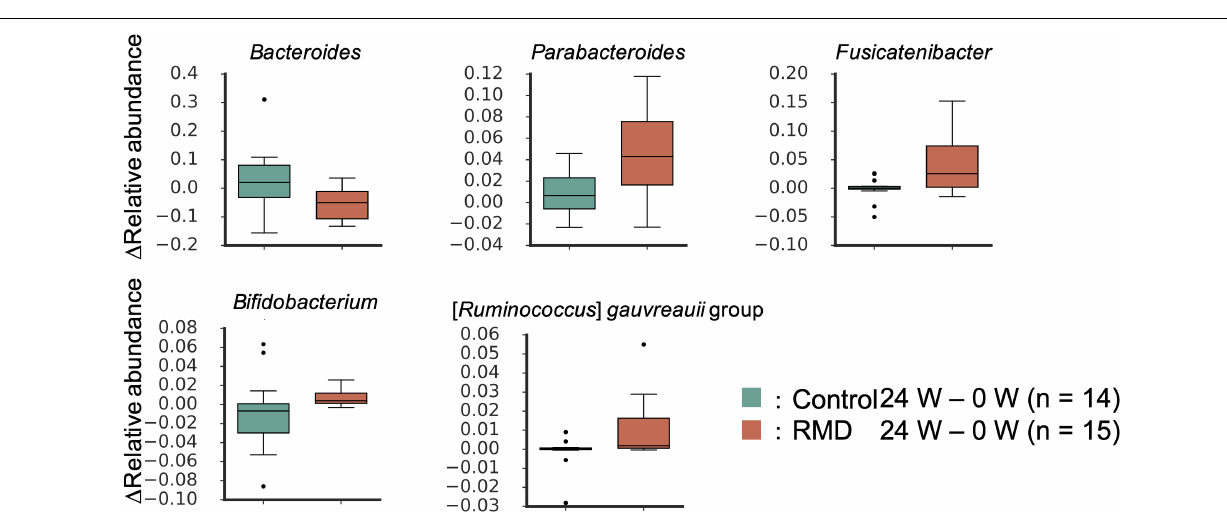
FIGURE 2 | Significantly altered gut microbes following RMD intake. Box plots showing significant differences between the control group and RMD group ( p < 0.05, the Wilcoxon rank sum test) and between before and after RMD intake ( q < 0.10, the Wilcoxon signed-rank